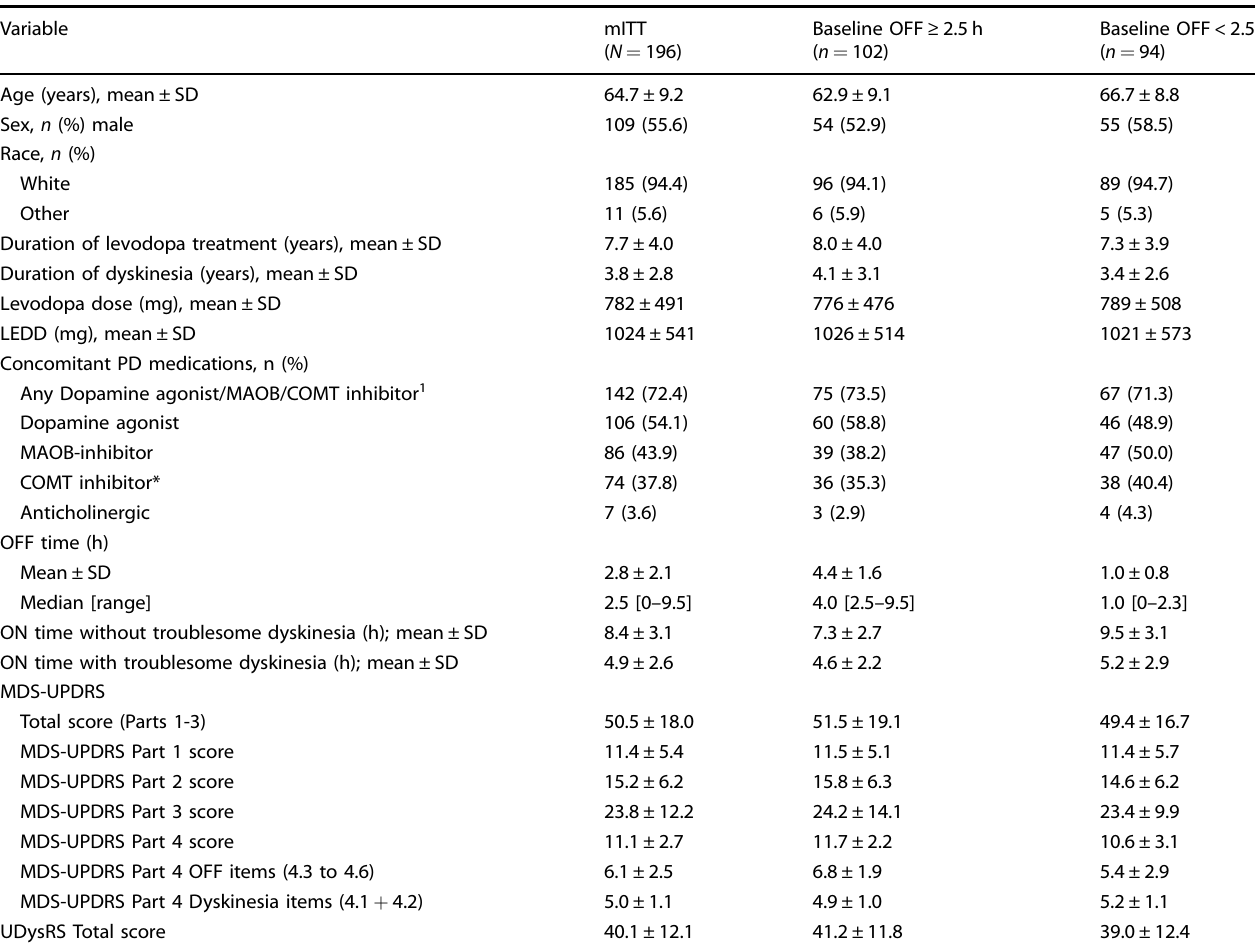
Table 1. Baseline characteristics.